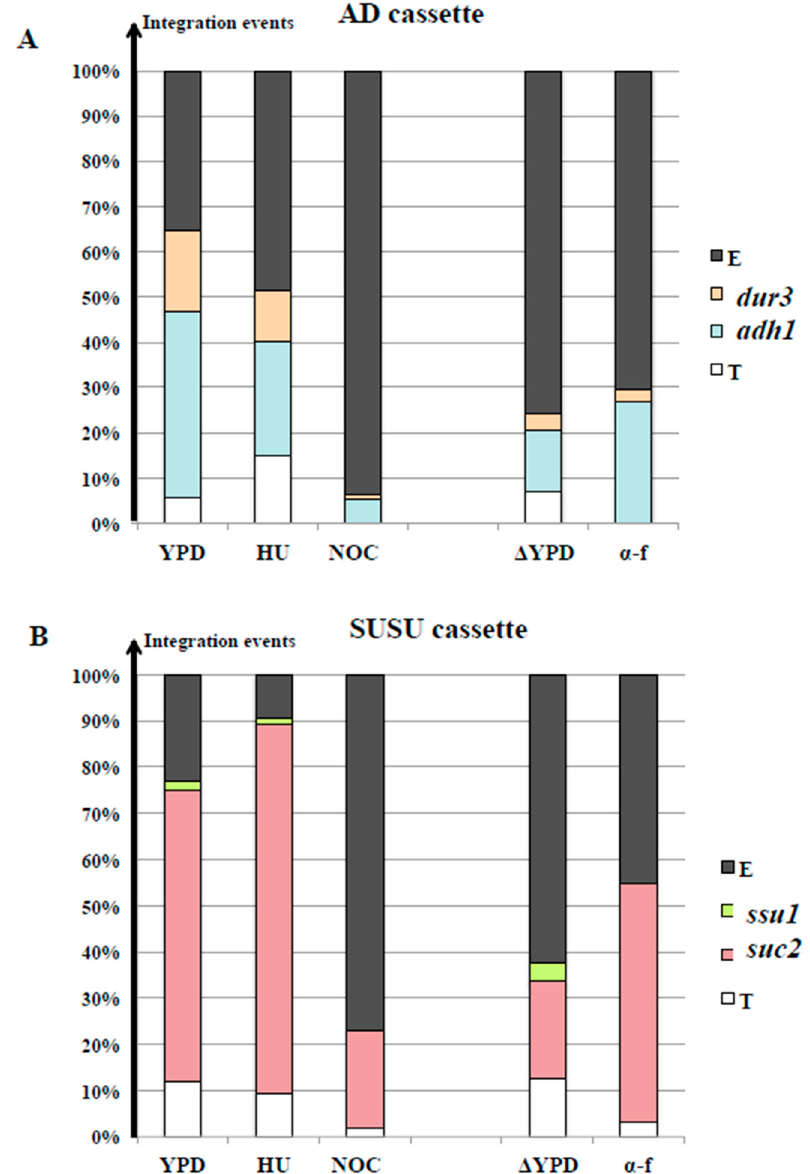
Figure 4. Percentage of integration events obtained using the XV–VIII and XVI–IX BIT cassettes. In this Figure, 100% represents the total amount of integration events. The raw data of the percentages used to plot the bars of the figure are reported in Table S2. ( A ) The three columns on the left show the percentage of translocation events (T, white), integration in adh1 only ( ADH1 , blue), in dur3 only ( DUR3 , orange) and of ectopic events (E, dark grey) obtained using the XV-VIII BIT cassette in an asynchronous cell population of San1 (indicated as YPD) and in populations synchronized either with HU or with NOC. The distribution of the events in cells synchronized with α -f is separately reported because only these data have been compared with the asynchronous strain San1VT Δ MAT (also reported in the figure and indicated as Δ YPD). ( B ) The three columns on the left show the percentage of the translocation event (T, white), integration in ssu1 ( SSU1 , green), suc2 ( SUC2 , red) and ectopic events (E, dark grey) obtained using the XVI–IX BIT DNA cassette in an asynchronous cell population (indicated as YPD) and in yeast cells synchronized either with HU or NOC. The data obtained with cells blocked using α -f are shown on the right and are compared with the strain San1VT Δ MAT (indicated as Δ YPD).